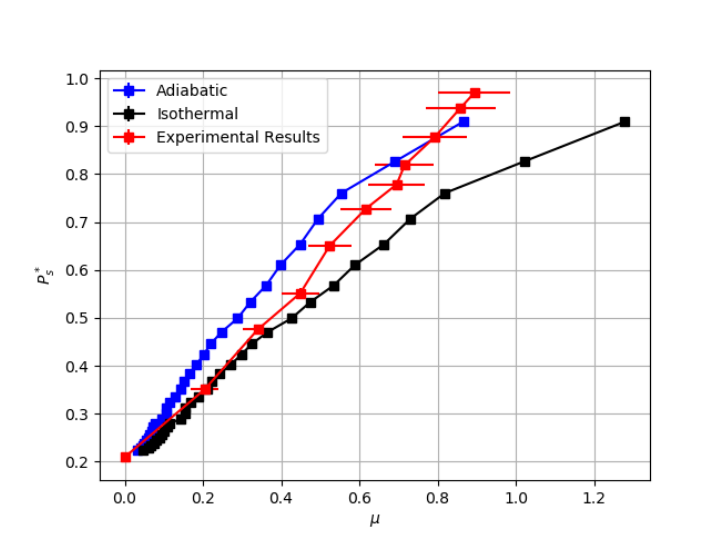
Figure 7. Transient evacuation from adiabatic to isothermal polytropic